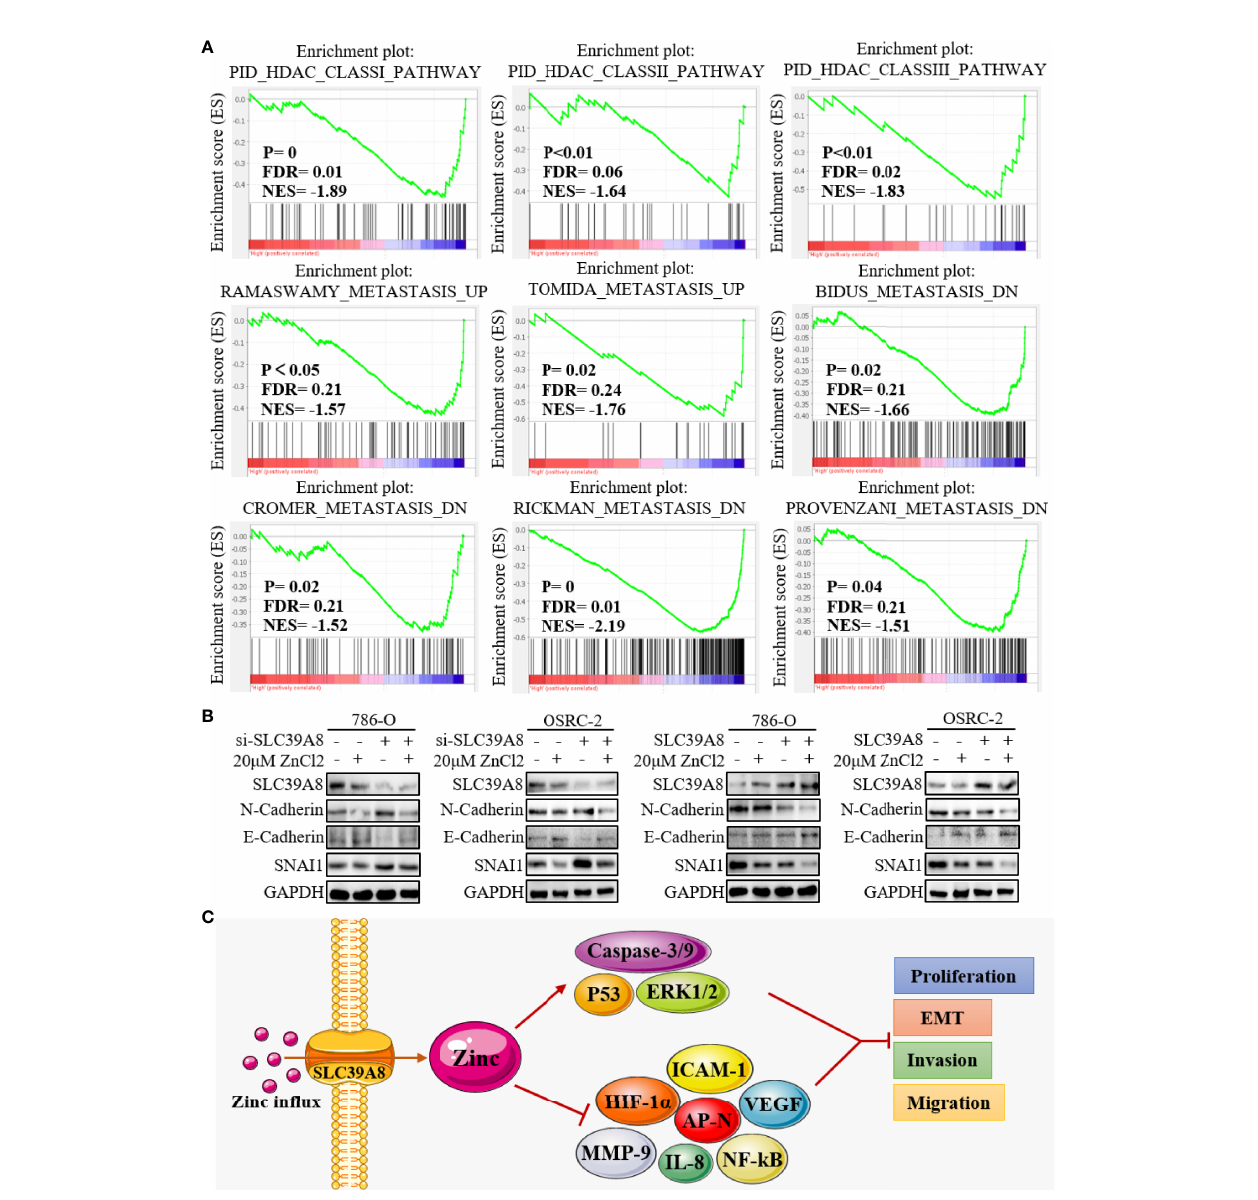
FIGURE 7 | Mechanism of SLC39A8/zinc inhibiting cell migration and invasion. (A) GSEA showed that the group with low expression of SLC39A8 was signi fi cantly associated with HDAC and metastasis pathway. (B) Western blotting experiments detected the effect of SLC39A8/zinc on EMT in ccRCC cells. 786-O and OSRC-2 cells transfected with si − SLC39A8 (knockdown), SLC39A8 (overexpression), and their corresponding control were used for this study. (C) A possible mechanism for SLC39A8/zinc inhibits the EMT of ccRCC cells. HDAC, histone deacetylase; EMT, epithelial-mesenchymal transition; ICAM-1, intercellular adhesion molecule 1; AP- N, aminopeptidase N; NF-kB, nuclear factor kappa B; VEGF, vascular endothelial growth factor; IL-8, interleukin 8; MMP-9, matrix metallopeptidase 9; HIF-1 a , hypoxia inducible factor-1 a ; ERK1/2, extracellular signal-regulated kinase